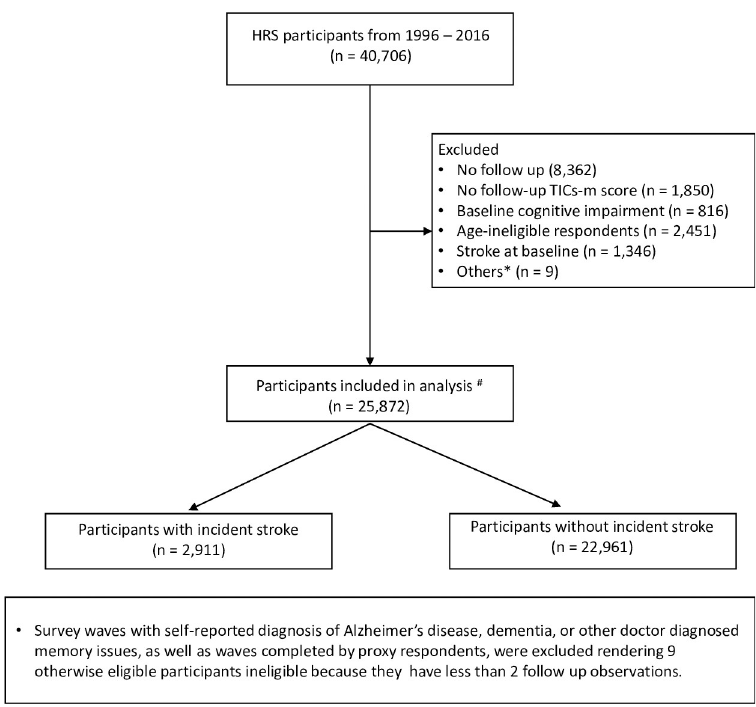
Fig 1. Participant selection flow